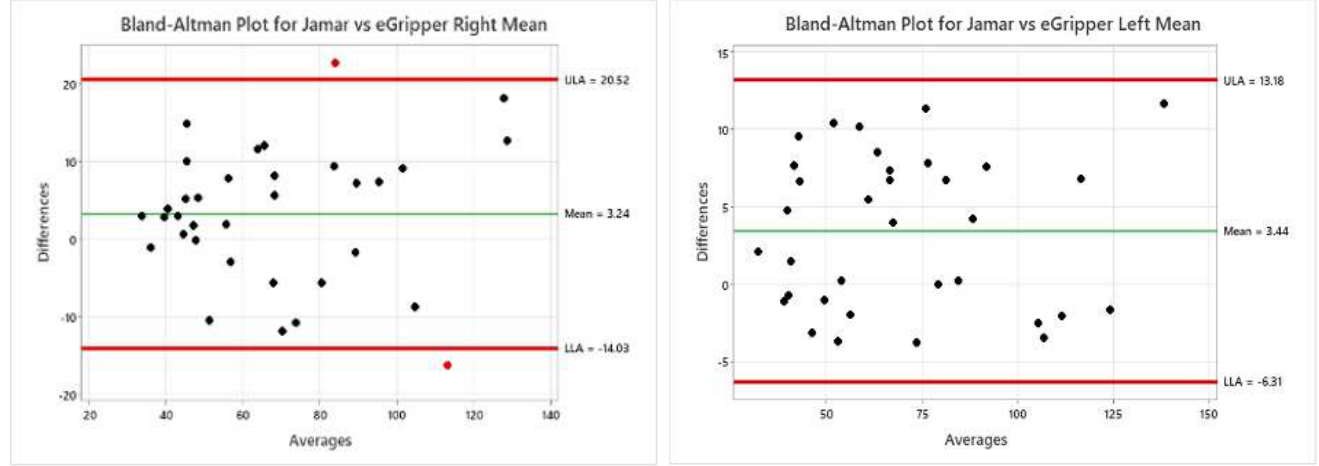
Figure 9 Bland-Altman Plot to Show Agreement between the Two